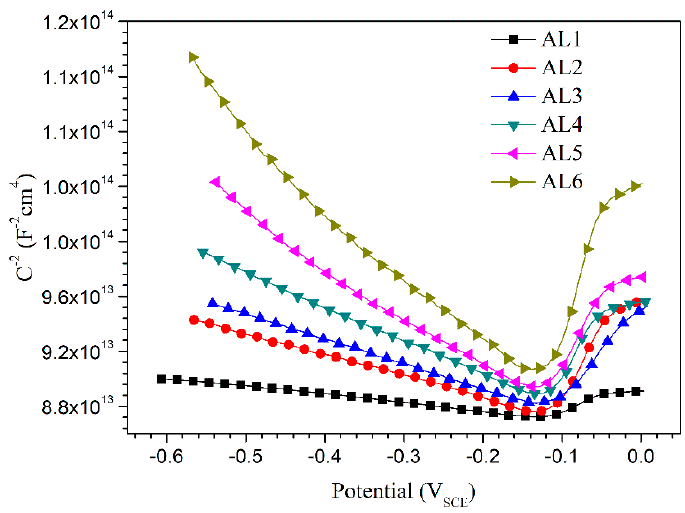
Figure 7. Typical Mott–Schottky test curves of sintered 7075 alloys after 6 h immersion in 0.2 M Na 2 SO 4 + 0.01 M NaCl